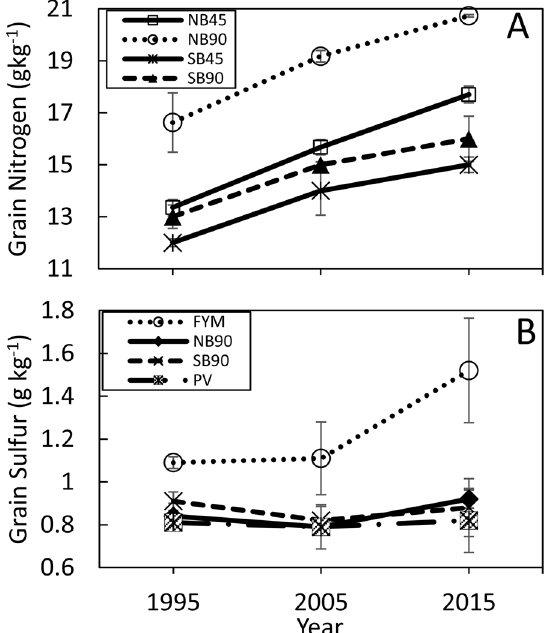
Figure 4. Effect of nitrogen (N) rates on grain N over time ( A ) and effect of organic amendments and N on grain S over time ( B ). FB = fall burn; FYM = Farmyard manure; NB, NB45 and NB90 = No burn with N applied at 0 kg ha − 1 , 45 kg ha − 1 , and 90 kg ha − 1 , respectively; PV = pea vine; SB, SB45 and SB90 = spring burn with N applied at 0 kg ha − 1 , 45 kg ha − 1 , and 90 kg ha − 1 ,